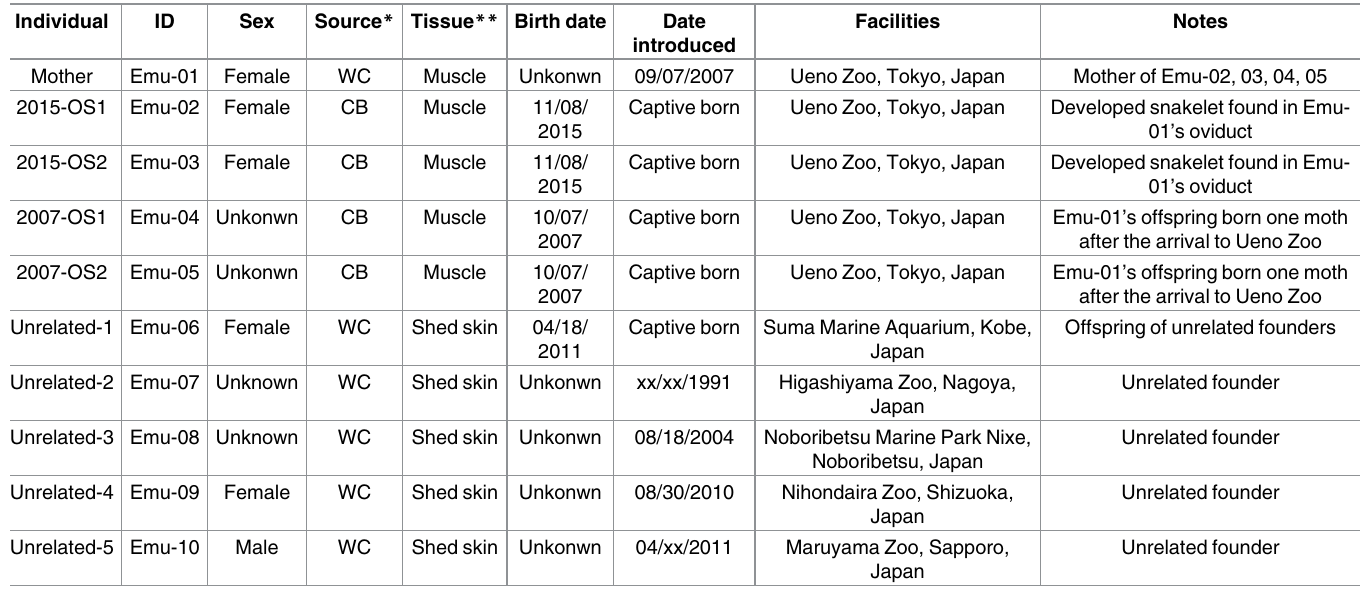
Table 1. Eunectes murinus samples